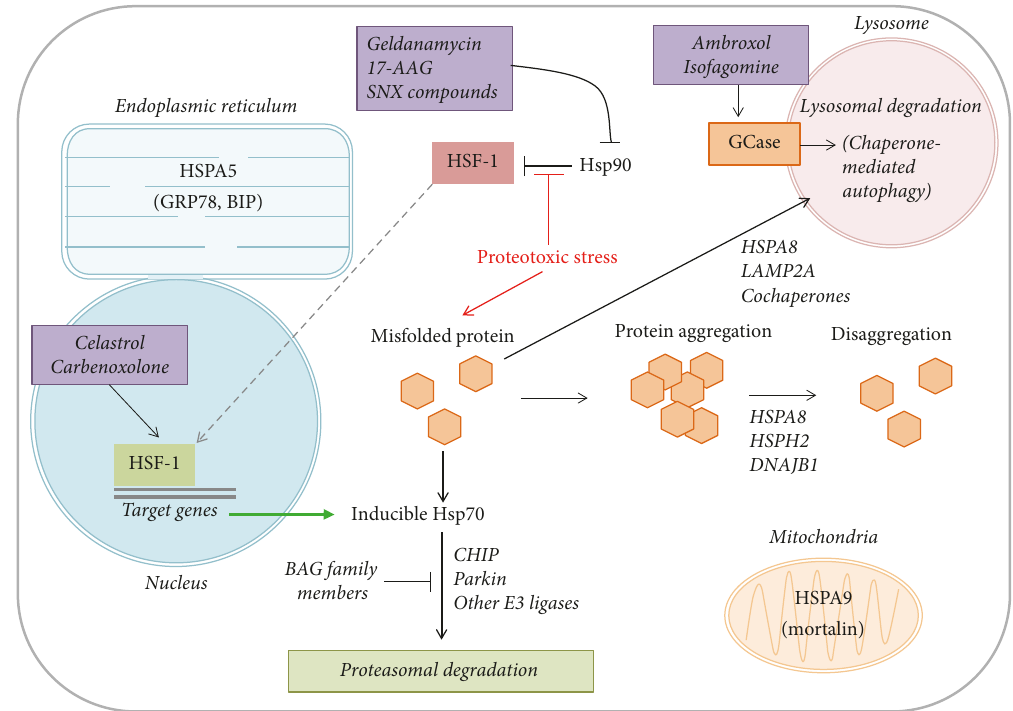
Figure 1: Proposed role of molecular and small molecule chaperones in proteostasis. At baseline, Hsp90 is bound to HSF-1, maintaining its inactive state. In the presence of proteotoxic stress, or the addition of Hsp90 inhibitors (i.e., geldanamycin, 17-AAG, and SNX compounds), active HSF-1 dissociates from Hsp90 and translocates into the nucleus where it induces Hsp70 expression. Inducible Hsp70 family members direct proteasomal degradation through a pathway mediated by CHIP, Parkin, and other E3 ligases. This process is inhibited by BAG family members and promoted by small molecule HSF-1 activators including celastrol and carbenoxolone. In response to proteotoxic stress, chaperones also direct misfolded proteins for degradation via the autophagy-lysosome system, through interactions with various cochaperones(chaperone-mediatedautophagy).Chaperone/cochaperonecomplexescanalsofunctiontodisaggregatealreadyformedprotein aggregates. The pharmacological chaperones, ambroxol, and isofagomine increase glucocerebrosidase (GCase) activity in the lysosome to further promote the process of chaperone-mediated autophagy. Chaperone functions within the endoplasmic reticulum and mitochondria are regulated by the specific members of the Hsp70 family, HSPA5 and HSPA9,